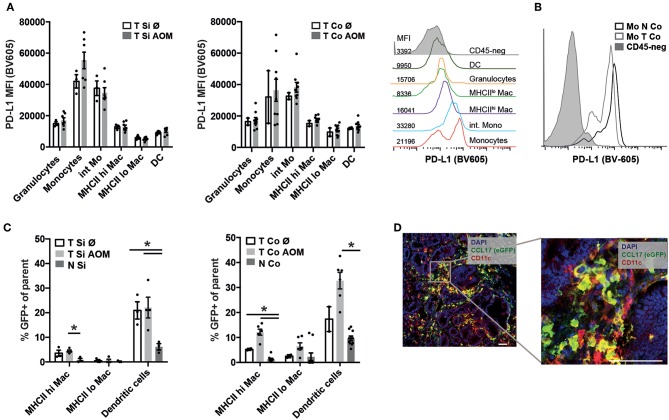
PD-L1 and CCL17 (eGFP) expression in intestinal tumors indicates establishment of a tumor promoting microenvironment. (A) PD-L1 mean fluorescence intensity (MFI) of the indicated myeloid cell populations in Si and Co tumors of untreated and AOM treated Apc1638N/+ mice. Representative histogram overlay of the PD-L1 fluorescence signal in the indicated myeloid cell populations (colored histograms) and CD45-negative tumor cells (gray histogram) from colonic intratumoral cells of an AOM-treated mouse. (B) Representative histogram overlay of the PD-L1 fluorescence signal in monocytes from tumor (light gray, open histogram) and normal (dark gray, open histogram) tissue, compared to CD45-negative cells (gray, filled histogram) from colonic intratumoral cells of an AOM-treated mouse. (C) CCL17-eGFP expression was detected by flow cytometry in macrophages and DCs in tumors and normal lamina propria of Apc1638N/+;CCL17-eGFP-reporter mice. The percentages of GFP+ cells within the indicated populations are shown. (A,C) Each symbol represents an individual mouse. Horizontal bars: mean, error bars: SEM, n = 2–9, unpaired two-tailed t-test. (D) Immunofluorescence staining (left: 20× magnification, scale bar 50 μm) of Si tumor tissue of an AOM-treated mouse. Blue: nuclear staining (DAPI), red: CD11c, green: CCL17-reporter (eGFP). *p < 0.05.